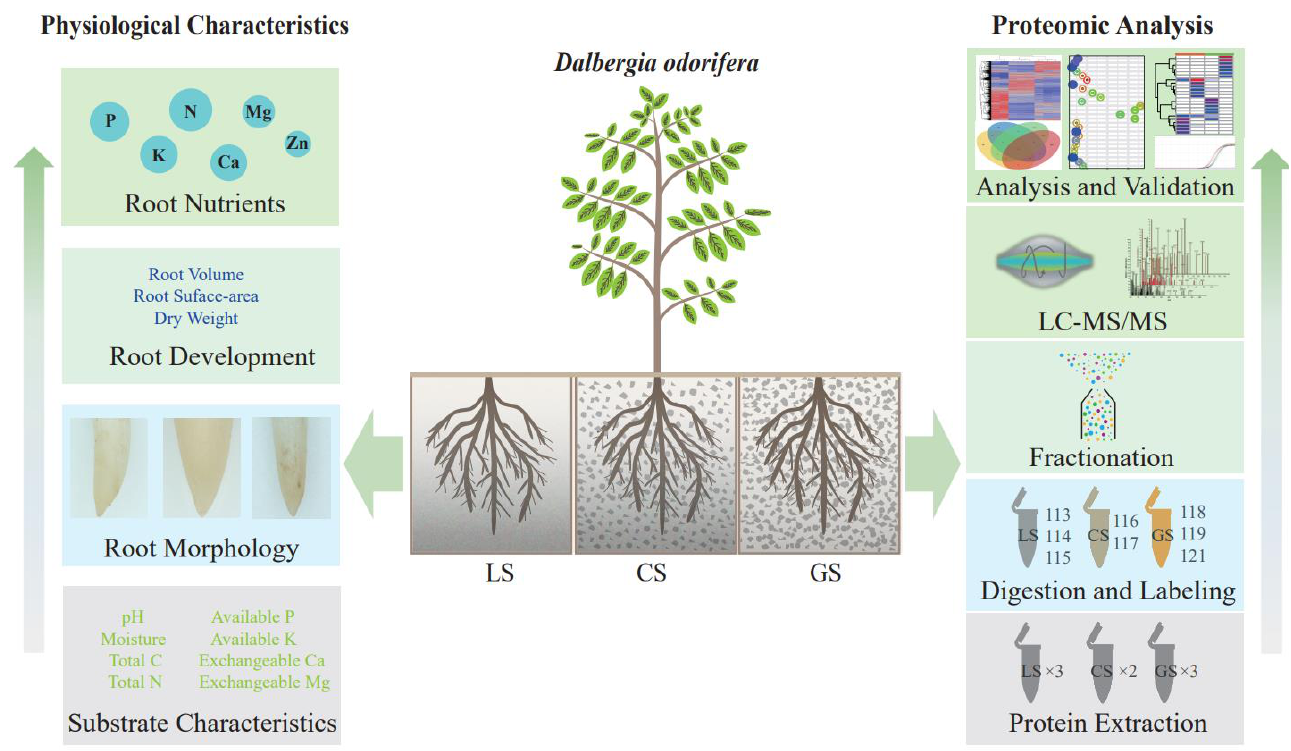
Figure 1. The workflow of physiological and proteomic studies of D. odorifera in loam and gravel substrates. LS: loam substrate, CS: composite substrate (50% gravel), and GS: gravel substrate (100% gravel).